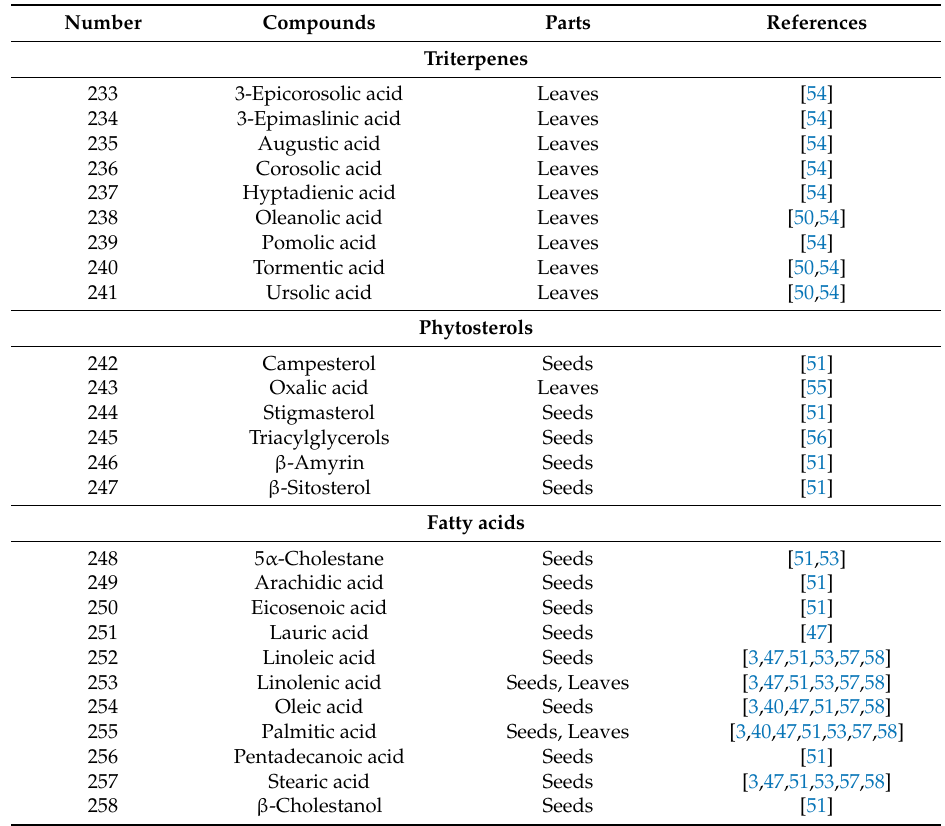
Table 3. Triterpenes, phytosterols, fatty acids, polycosanol, and tocopherol compounds found in Perilla frutescens